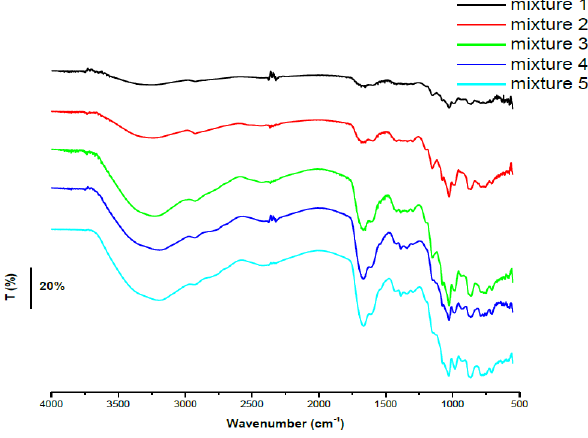
Figure 7. FTIR spectra for the five mixtures: (mixture 1) β-CD: AA: UA = 1:1:1,